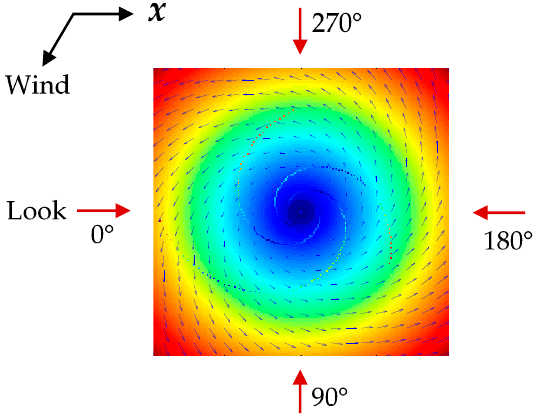
Figure 11. Four radar look directions with respect to the given current field. The red arrows represent the four radar look directions. The x axis of the current field and wind direction are indicated by black arrows. Table 5. The simulation parameters of Figure 12.